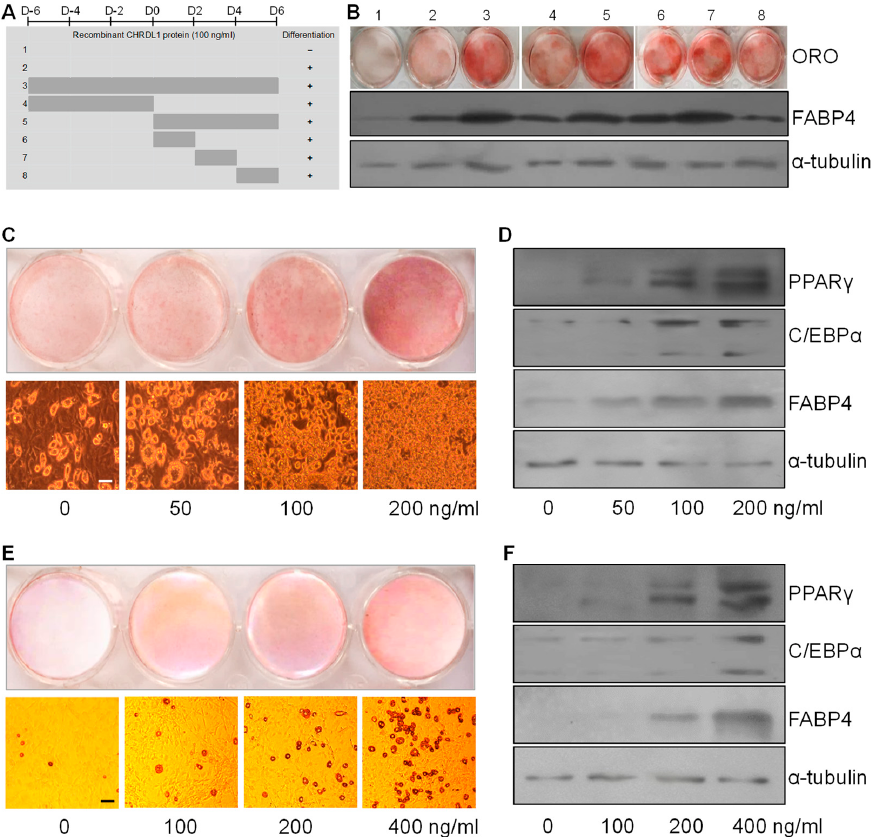
Figure 5. Induced and spontaneous adipogenic differentiation of 3T3-L1 cells with administration of CHRDL1 recombinant protein. ( A ) Schematic timetable of the search for a permissive stage of differentiation by CHRDL1. Adipogenic differentiation without (treatment 1 and 2) or with different periods of CHRDL1 recombinant protein treatment (100 ng/mL) denoted by grey parallel bars (treatment 3 through 8). D0, time of differentiation induction which was preceded or followed by 2-day intervals. − , no induction of di ff erentiation at D0; +, induction of differentiation at D0. ( B ) Oil Red O staining and Western blots of the adipogenic marker FABP4 at day 8 (D8) for each treatment in A. ( C ) Dose-dependent effects of administered CHRDL1 recombinant protein on induced 3T3-L1 adipocyte differentiation and lipid accumulation. The experiment was performed in duplicate. ( D ) Western blots of adipogenic markers with the proteins harvested from C. ( E ) Spontaneous differentiation of 3T3-L1 preadipocytes along with administration of indicated doses of CHRDL1 recombinant protein. The experiment was performed in duplicate. ( F ) Western blot analysis of adipogenic markers for the proteins collected from E. The α -tubulin protein was used as a loading control. Scale bars indicate 100 µm.